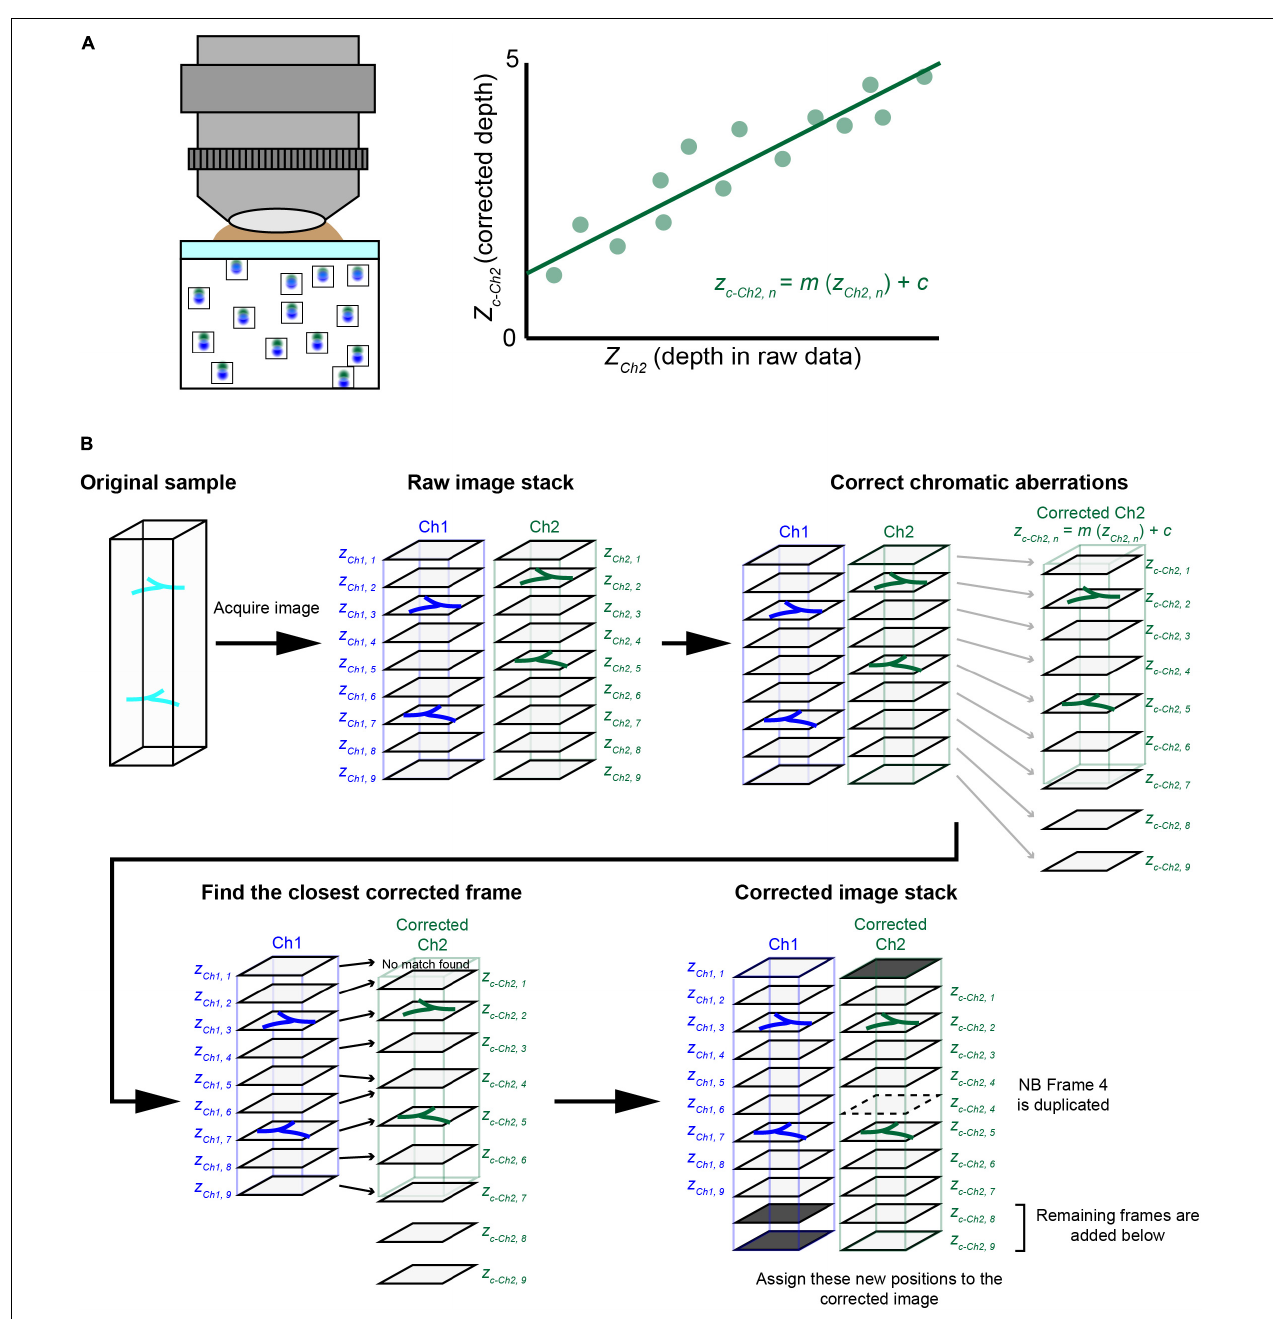
FIGURE 4 | The chromatic aberration correction pipeline. (A) We developed a chromatic aberration correction pipeline. After calculating the depth-dependent axial chromatic shifts, we assigned a correct frame of channel 2 (Ch2) for each frame of a reference channel 1 (Ch1). In one approach, we used a reference bead sample to obtain necessary parameters for the correction. We used agarose gel containing fluorescent beads to determine the relationship between depth and axial aberrations. We then obtained a regression equation to determine the corrected depth for Ch2, which should match that of Ch1. Another approach using guide stars within the sample is detailed in Figure 6 . (B) The post hoc correction pipeline. After taking volumetric fluorescence images for Ch1 and Ch2, we assigned z depths (actual movement of the objective) for both Ch1 and Ch2. Due to chromatic aberrations, the z position for Ch2 ( z Ch 2 , n ) is shifted relative to Ch1 (zCh1, n). We therefore calculated “corrected” z positions for Ch2 ( z c - Ch 2 , n ), which should be consistent with z Ch 1 , n . Then, for each of the Ch1 frames, we assigned a Ch2 frame with the closest z c - Ch 2 , n value. In the new image stack after this correction, the chromatic aberration will be fully cancelled. Occasionally, some Ch2 frames will be deleted or